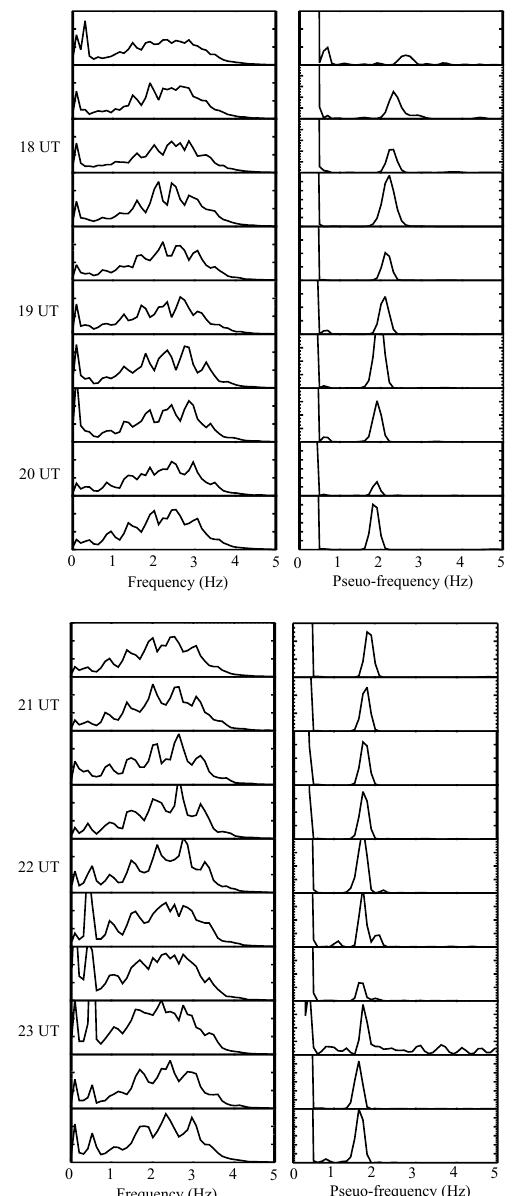
Figure 6. Columns 1 and 3 show the 20 minute averaged power spectral density for the H component polarization magnetic field variation at Sodankyla on 04/10/98. This is uncalibrated and plots magnetic field power spectral density (arbitrary amplitude) as a function of frequency. Columns 2 and 4 show the Fast Fourier Transforms of these power spectra, such that the peak in pseudo- frequency indicates the periodicity in frequency in columns 1 and 3 due to the Alfven wave harmonics resonating within the IAR. The peak in pseudo-frequency decreases from ~2.4 Hz-1.7 Hz from 17-22 UT. This indicates that the frequency spacing of the IAR harmonics increases over the time interval from 0.4 Hz-0.6 Hz.